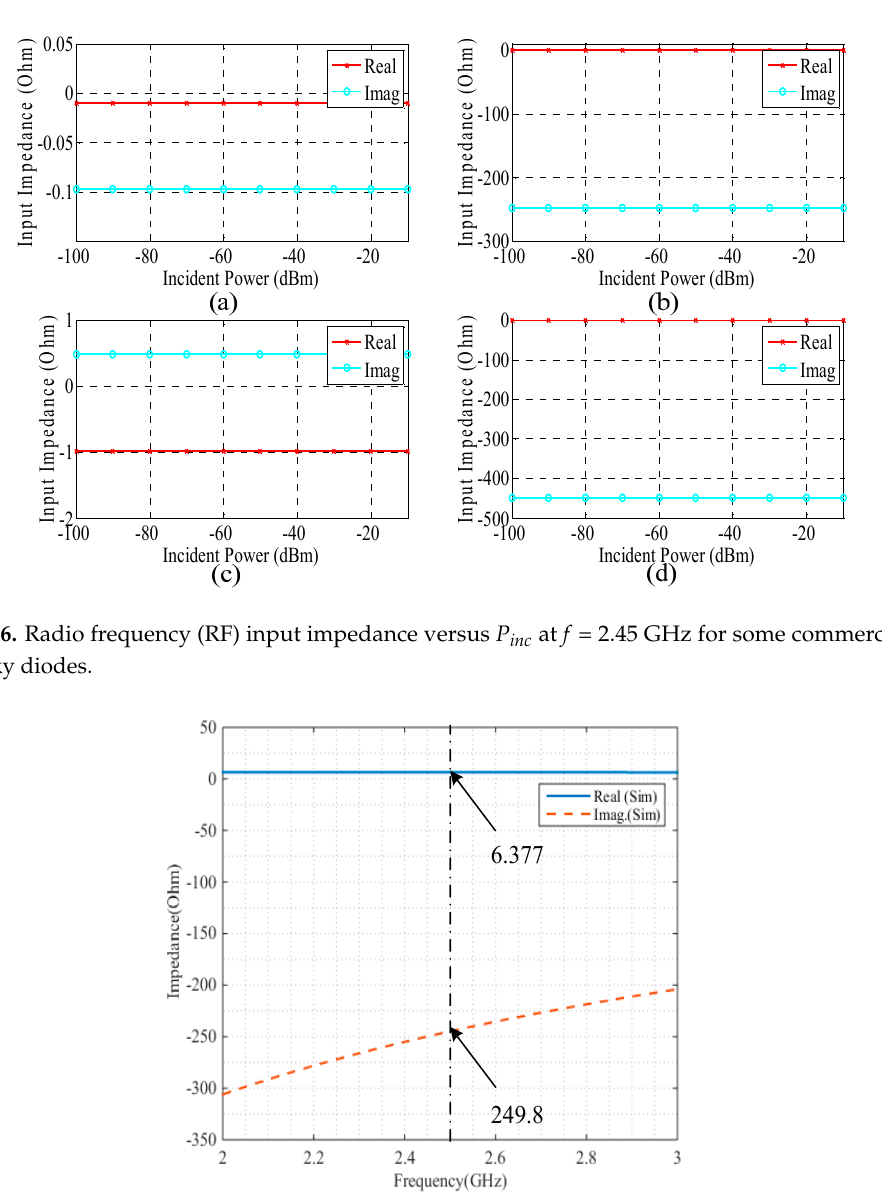
Figure 7. The input impedance of the rectifier/switching circuit versus frequencies.